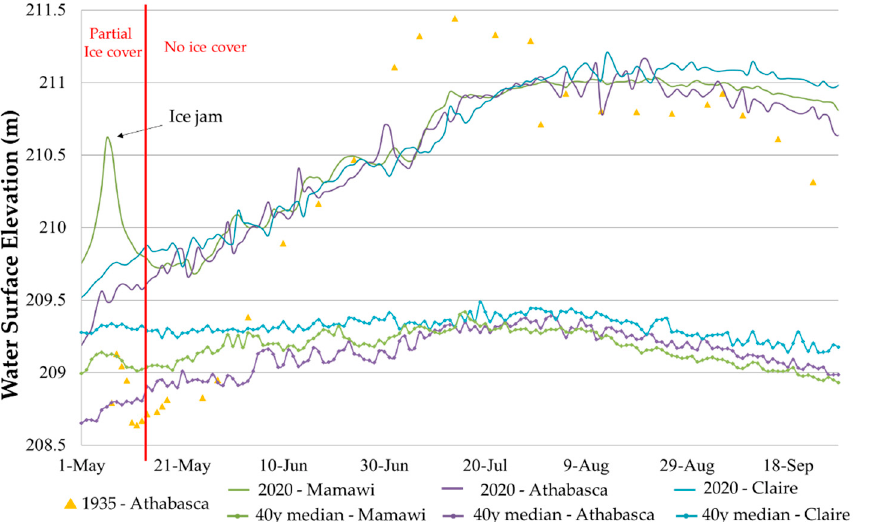
Figure 2. 2020 flood event compared to the 40-year median and the 1935 flood event [37] for Lakes Claire, Mamawi and Athabasca.